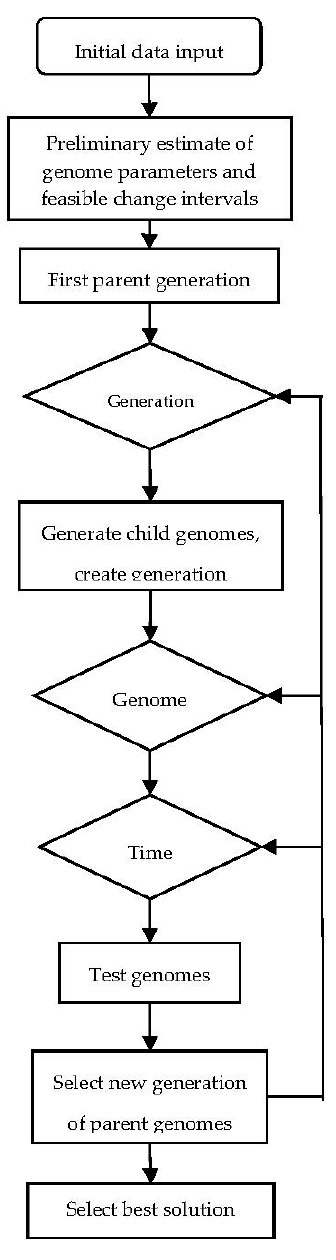
Figure 8. A functional block diagram of evolutionary adaptation.